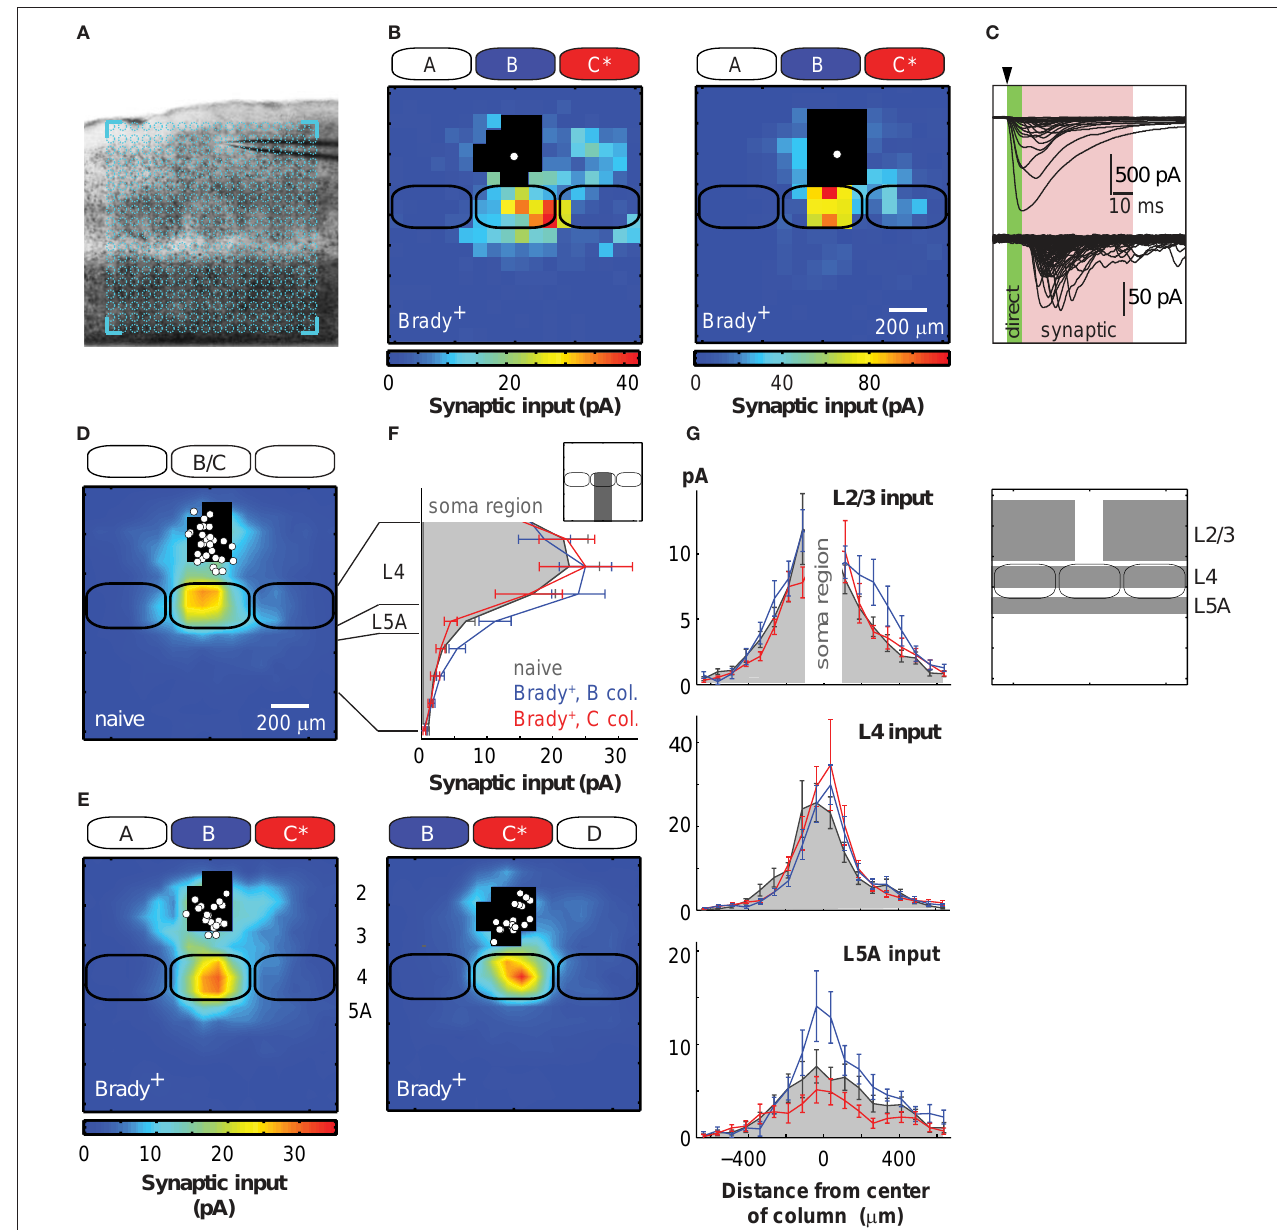
pulse (pink). (D) Average synaptic input map for naive mice ( n = 28). Maps centered over the B ( n = 17) and C ( n = 11) columns were pooled as they were similar. (e) Synaptic input maps for Brady + mice centered over the B column (left, n = 19) and the C column (right, n = 17). (F) Vertical profile (75 μm bins) of synaptic inputs for L2/3 cells recorded in naive mice (solid gray) and for L2/3 cells recorded in the B (blue) and C (red) columns of Brady + mice. (g) Horizontal profiles of synaptic inputs received by L2/3 cells in naive (solid gray) and Brady + mice (B column, blue; C column, red). In insets, the regions where the